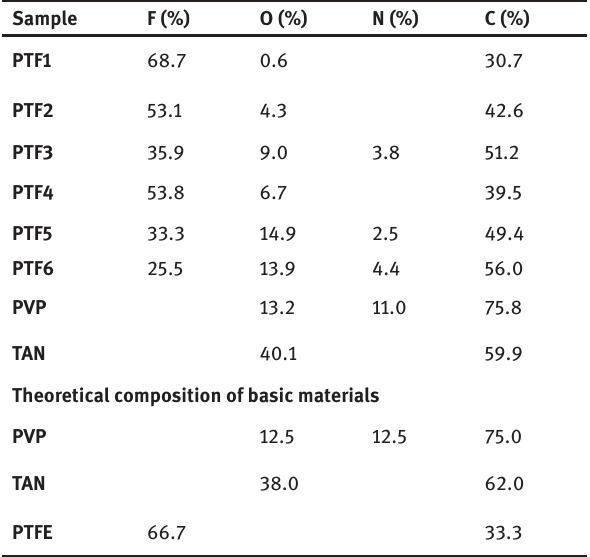
Table 2: Surface composition (atomic %) of untreated and various plasma-treated PTFE samples, together with the theoretical